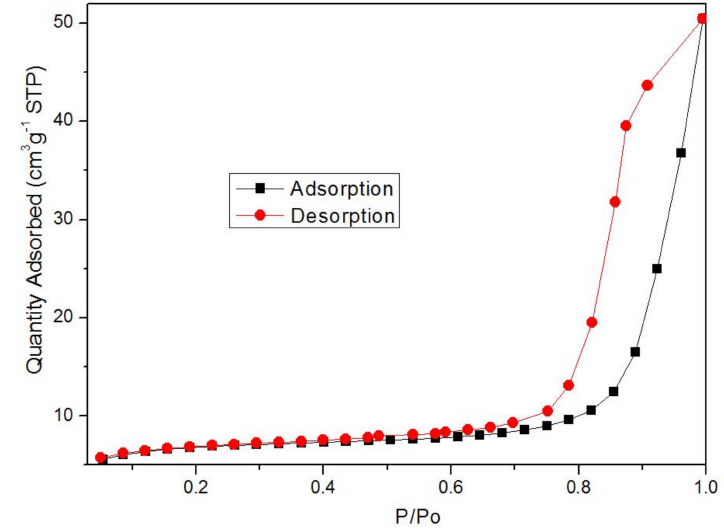
Figure 4. N 2 adsorption–desorption isotherms of